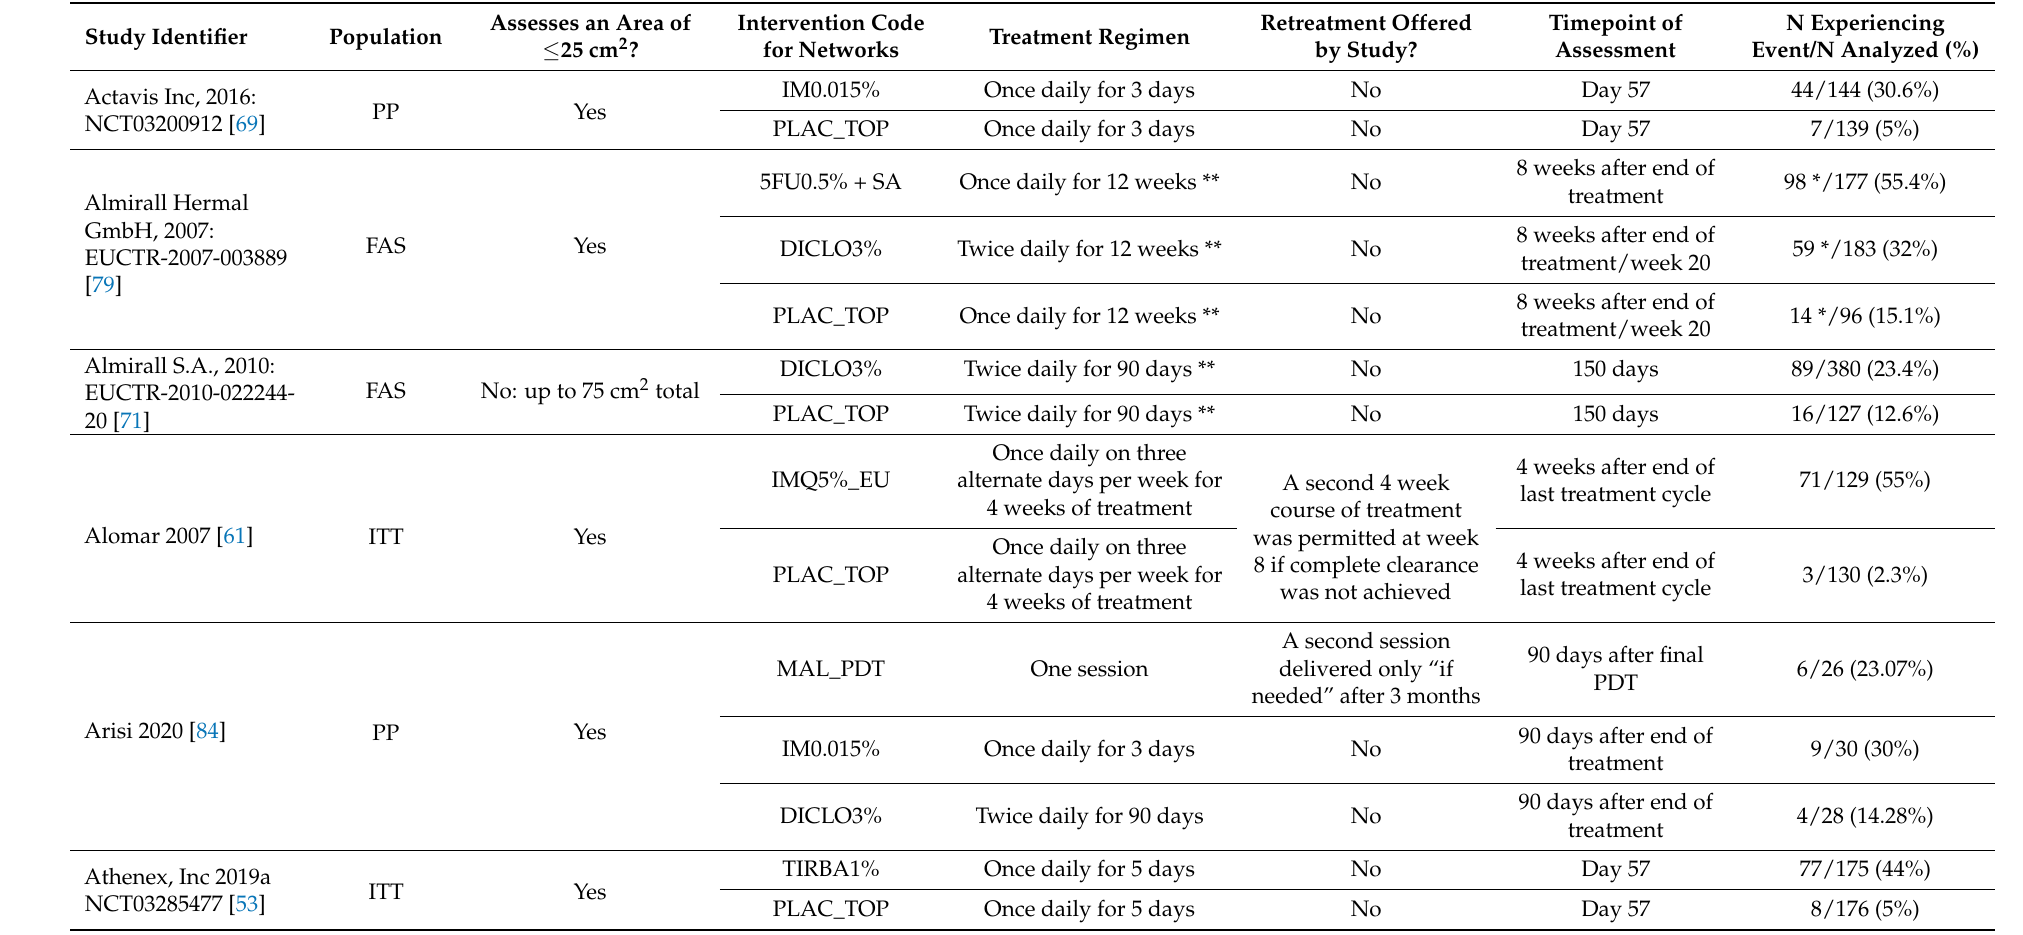
Table 4. Complete clearance data eligible for inclusion in the European